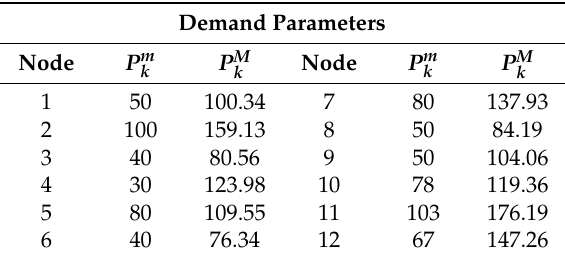
Table 3. Parameters of EUs for IEEE 39-BUS